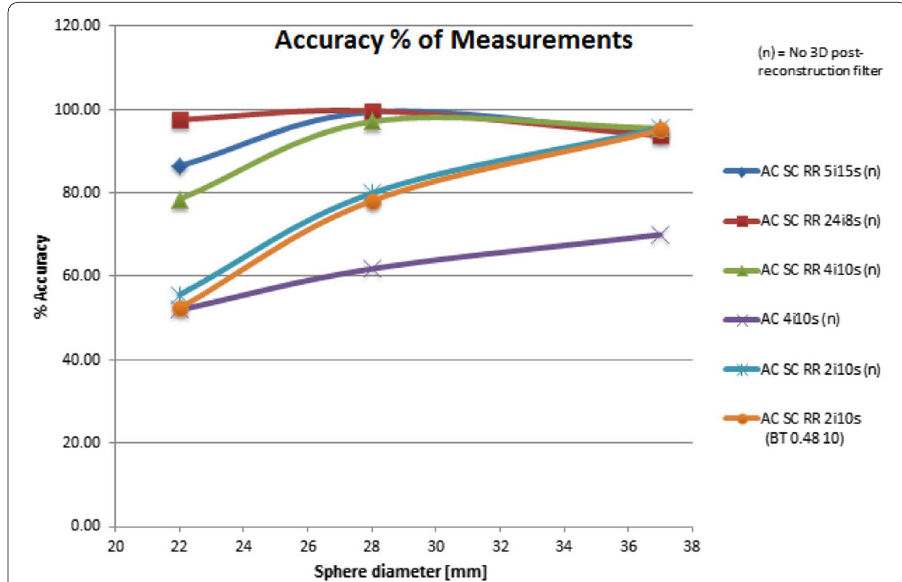
Fig. 10 Accuracy of measurements for activity in the 3 largest spheres of the NEMA/IEC Body Phantom scanned in GE Healthcare laboratory. Source: White Paper, DOC1951185, 2017, GE